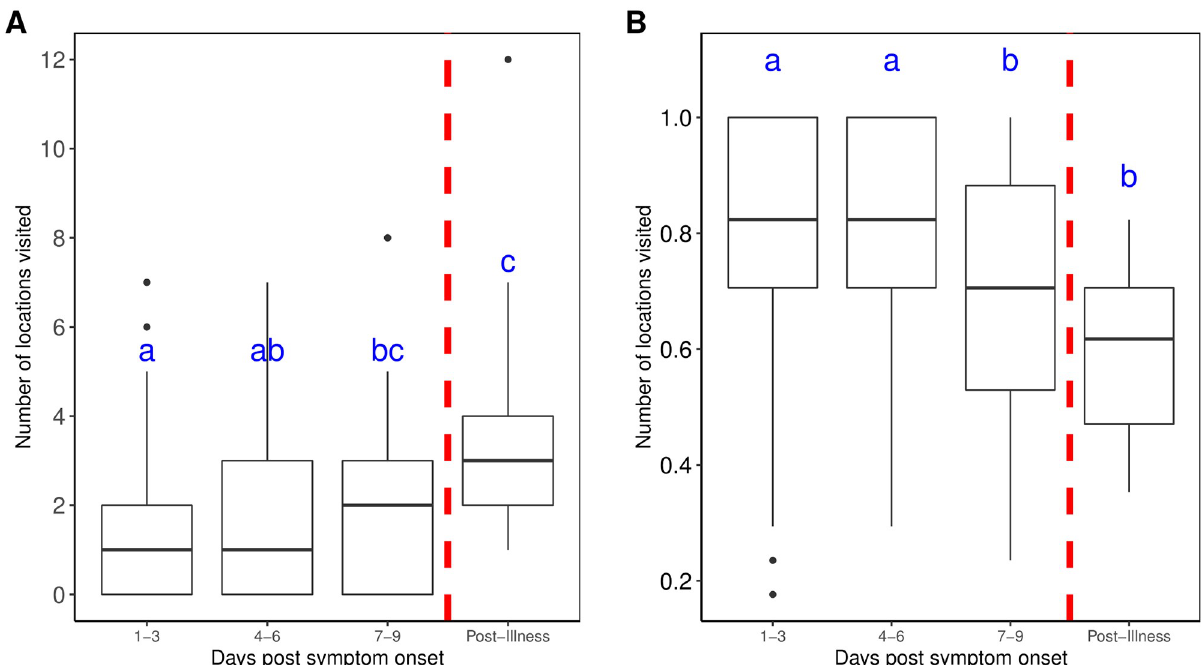
Fig 3. Mobility values during illness (in 3-day intervals). (A) Average number of locations visited per 3-day period. (B) Average proportion of time spent at home per 3-day period. Significant differences, denoted by letters, were detected using pairwise paired Wilcoxon Sign Rank tests with Bonferroni’s correction to account for a family-wise error-rate of 0.05. All significant differences had p-values <